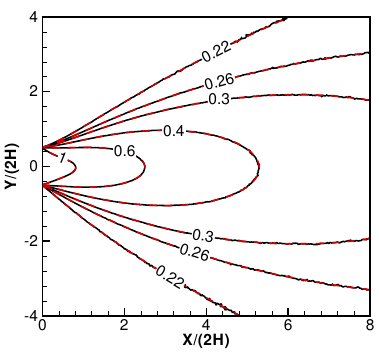
Figure 3. Nondimensional density contours for the jet/background mixture, n b / n 0 = 0.2, S 0 = 2.0, α 0 = 45 ◦ , S b = 1.0, T 0 = 200 Kelvin, and T b = 300 Kelvin. Red: analytical, black: direct simulation Monte Carlo (DSMC).